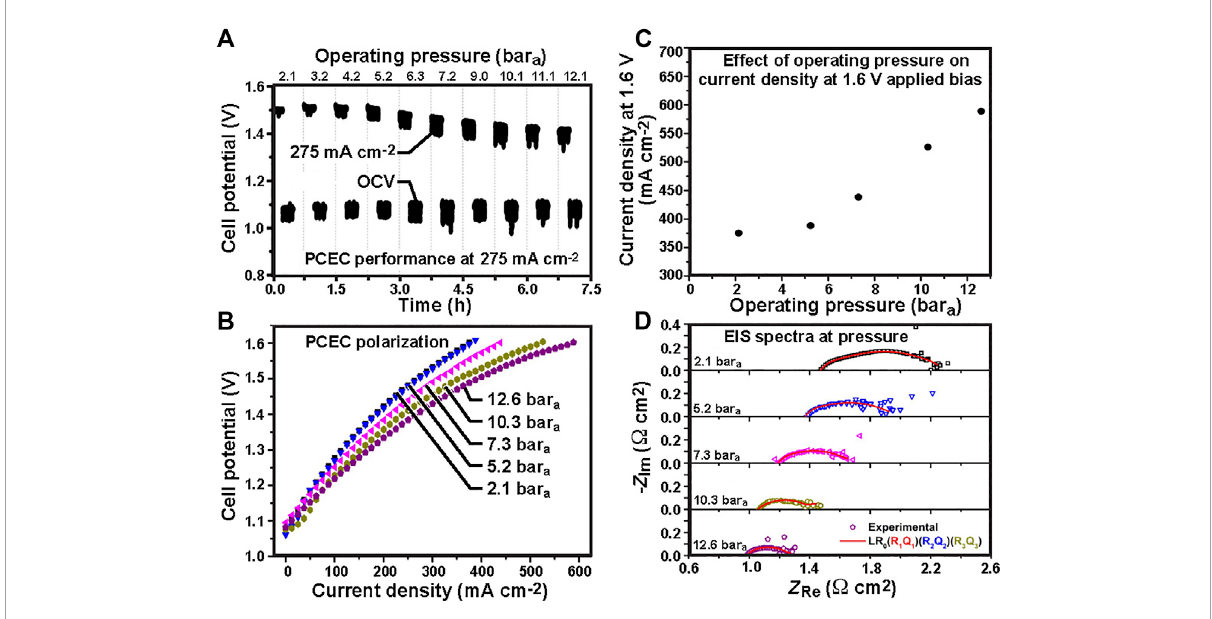
FIGURE 3 Protonic-ceramic electrolyzer performance from 2.1 to 12.1 bar a : (A) open-circuit voltage and driving voltage at 275 mA cm −2 over 7.5 h; (B) polarization behavior; (C) current density at 1.6 V driving voltage; and (D) electrochemical impedance spectra.